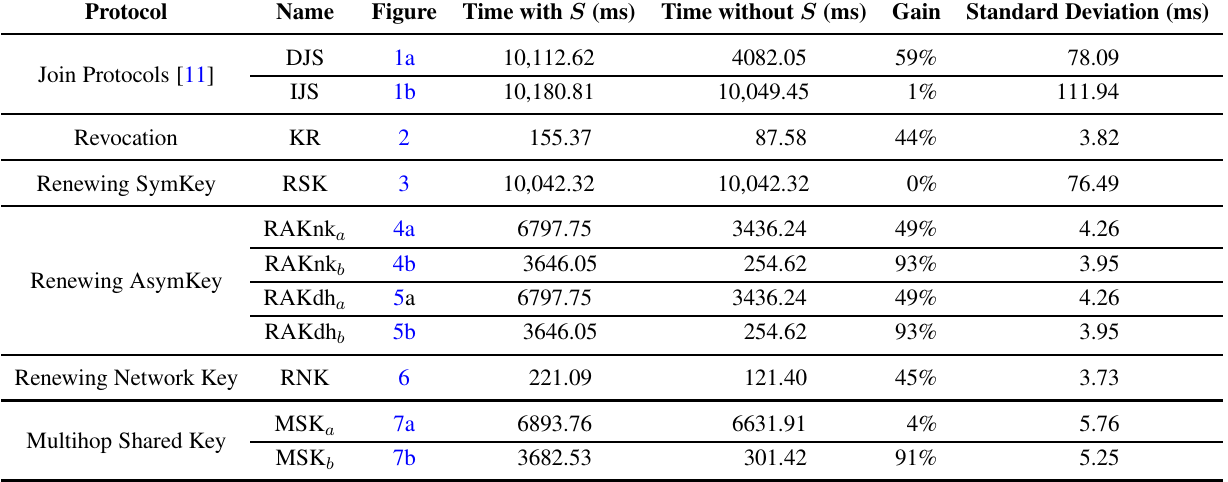
Figure 3. RSK: renewing a symmetric or session key. Table 2. Execution time of all